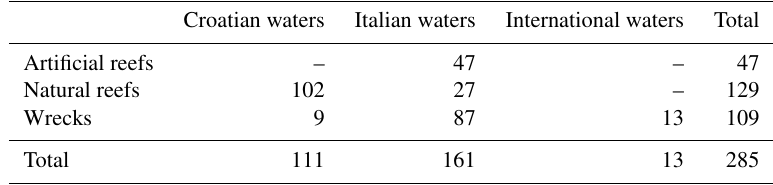
Table 1. Adriatic reefs and wrecks by typology and